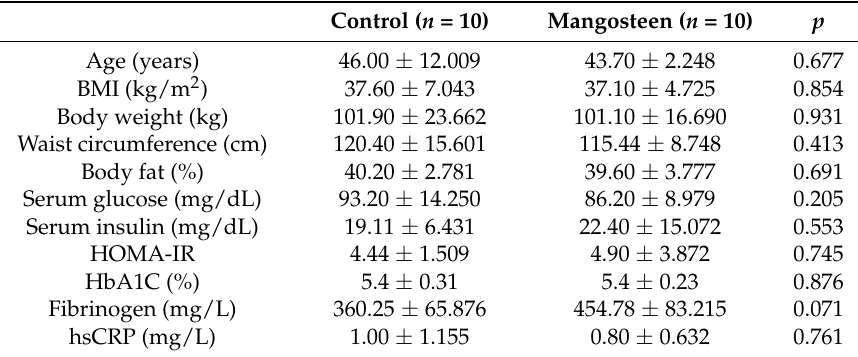
Table 2. General characteristics of the treatment arms. The groups were not significantly different at baseline in regard to age, BMI, body composition, glucose metabolism, and inflammatory